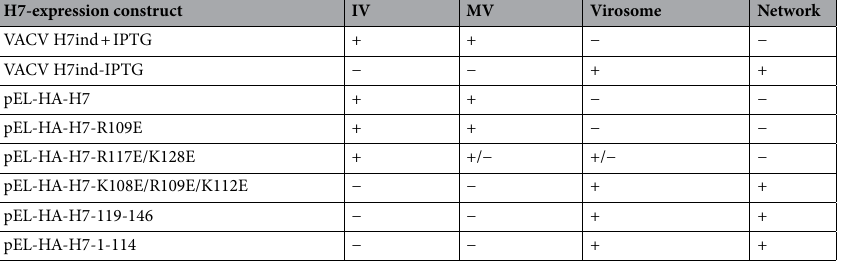
Table 1. Ability of various mutant H7 proteins to rescue the H7-phenotype. HeLa cells were infected with or without IPTG as positive and negative control, respectively. Cells infected without IPTG were transfected one hour after infection with the respective constructs where synthesis of the H7 constructs is driven by a synthetic early/late VACV promotor (pEL) and the expressed protein tagged with HA. Transfection efficiency was assessed by parallel fluorescent labeling using anti-HA and estimated to be roughly 90% in all experiments. Cell profiles were inspected for presence or not of viral forms, IVs, MVs, electron-dense virosomes or network structures (the latter two typically only appear when H7 is not synthesized or not functional). The full length (pEL-HA-H7) construct rescues the formation of IVs and MVs and virosomes and network structures are absent. All single point mutations also rescue IV and MV-formation and the results for the R109E mutant are shown as